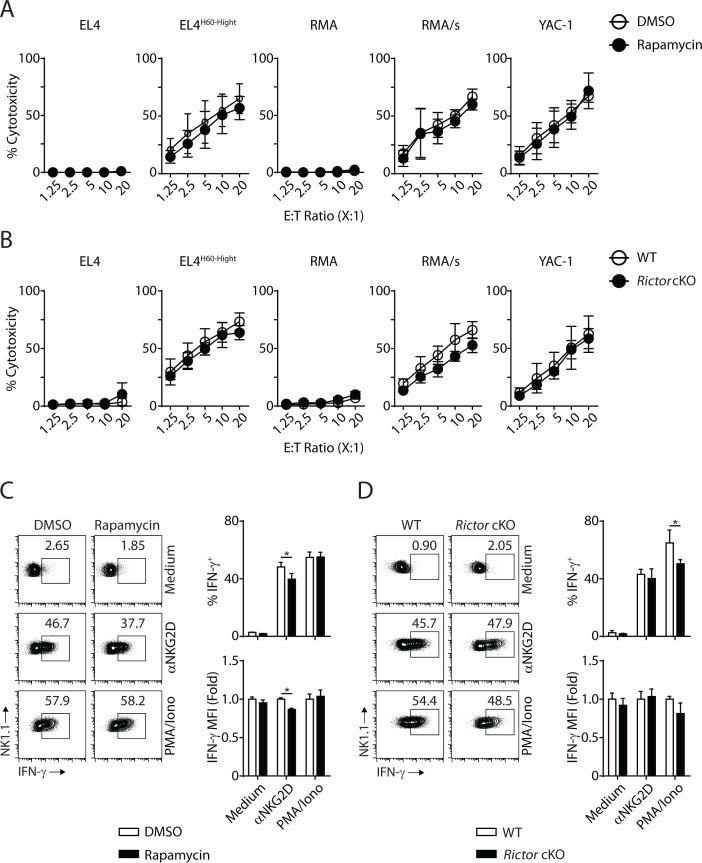
mTORC1 is essential for the IFN-γ generation downstream of NKG2D.(A) Standard 51Cr-release assay using IL-2-cultured WT NK cells against different target cells at various effector to target ratios in the presence of DMSO or Rapamycin (100 nM). n = 6 pooled from three independent experiments. (B) Standard 51Cr-release assay using IL-2-cultured WT and Rictor-deficient NK cells against different target cells at various effector to target ratios. n = 3 pooled from two independent experiments. (C) IL-2-cultured WT NK cells were stimulated with plate-bound NKG2D, PMA/Ionomycin or left along with medium in the presence of DMSO or Rapamycin (100 nM) for 6 hr. IFN-γ production was assessed via intracellular flow. n = 3 representative of three independent experiments. (D) IL-2-cultured WT or Rictor cKO NK cells were stimulated with plate-bound NKG2D, PMA/Ionomycin or left along with medium for 6 hr. IFN-γ production was assessed via intracellular flow. n = 3 pooled from two independent experiments. All bar graphs present the mean ± SD. Statistical significance was calculated using two-way ANOVA. *p<0.05; **p<0.01; ***p<0.001. List of other files.